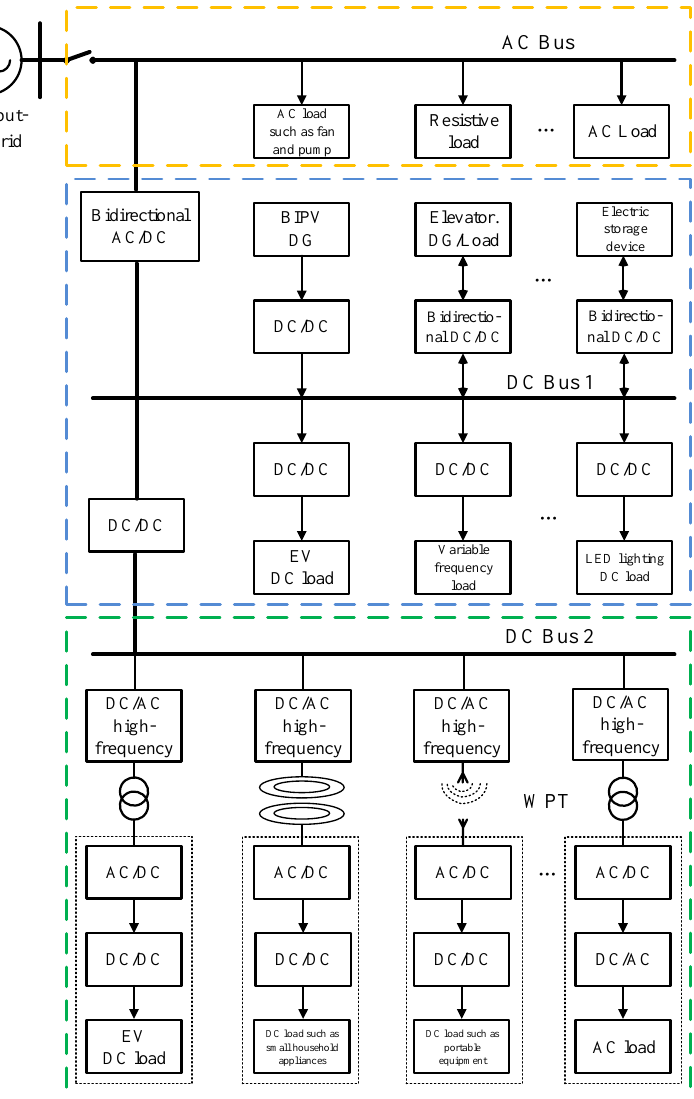
Figure 7. The architecture of the building power distribution system based on the demand-side.